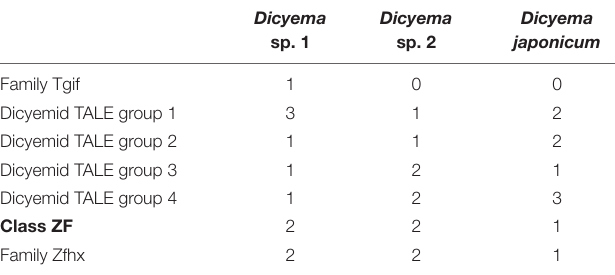
TABLE 2 | The list of homeodomain transcription factors in three species of Dicyemida.